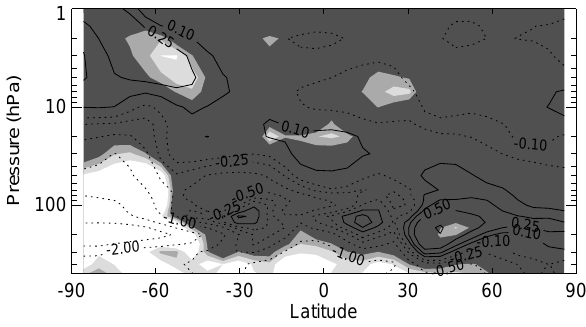
Fig. 4. The average of the residual of the fit of the (REF-B2 - GHG) ozone mixing ratio to EESC over the period 2060–2089, expressed as a percentage of the average ozone mixing ratio over the same time period. The shading indicates regions where the difference of the residual from zero is not statistically significant at the 98, 95 and 90% confidence level. The residual was calculated from the ensemble average annual average ozone mixing ratios (unsmoothed) and the calculation of statistical significance was based on a two-sided t-test accounting for lag-1 autocorrelation.